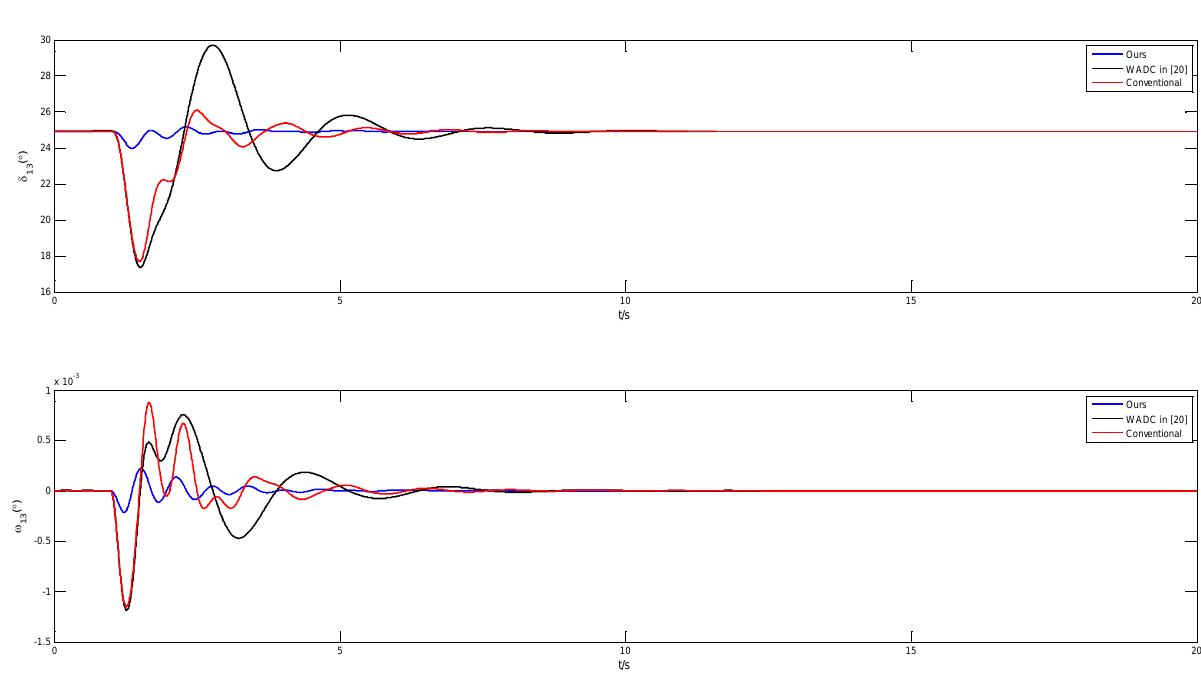
Figure 7. Response of the system in Scenario 3 when 𝜌 = 0 . Table 3. The key index of the response curve when there is no packet loss. Figure No.